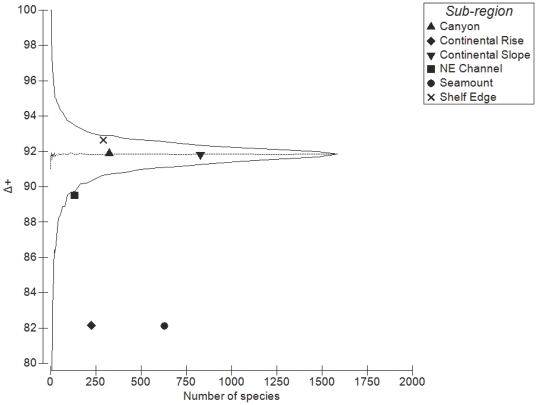
Average taxonomic distinctness (Δ+) by number of species for each sub-region.Central line is average taxonomic distinctness for the total list. Funnel lines are confidence limits within which 95% of simulated values lie.